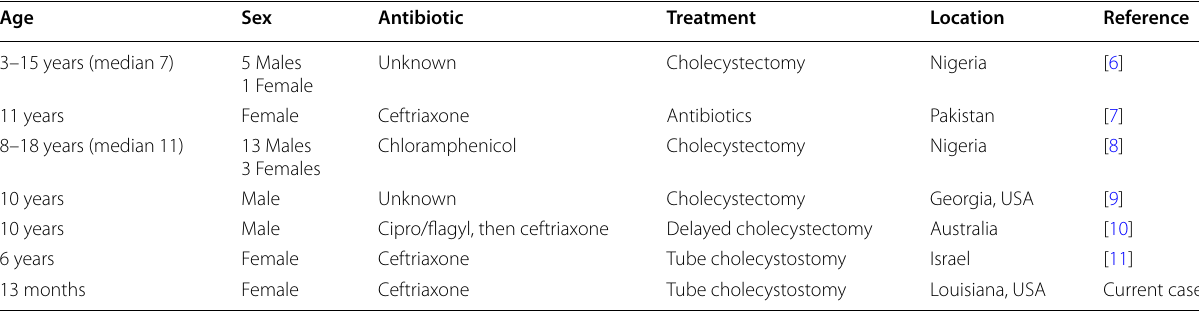
Table 1 Reported cases of acute acalculous cholecystitis due to Salmonella typhi in pediatric patients Age Sex Antibiotic Treatment